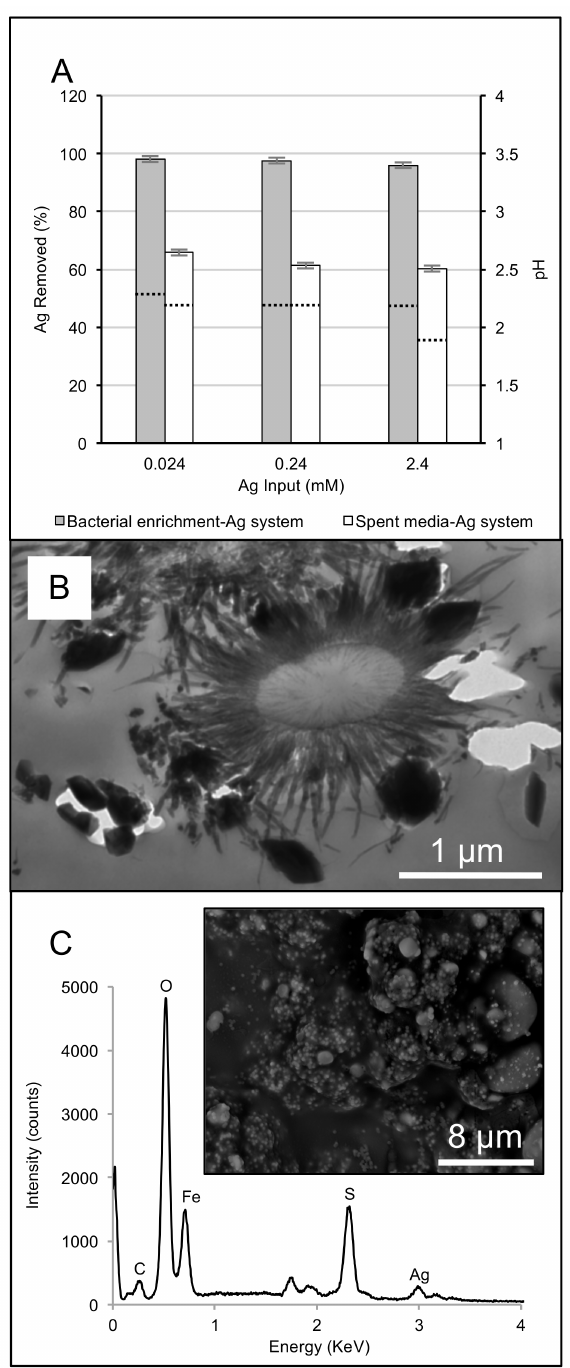
Figure 5. Average percent of Ag removed by the microbial enrichment- and spent medium-Ag systems based on ICP-AES analysis. Dashed lines represent pH within the corresponding experimental system ( A ); a high-resolution TEM micrograph of a mineralized cell and nanometer-scale argentojarosite from a microbial enrichment-Ag system exposed to 2.40 mM Ag ( B ); a low resolution BSC SEM micrograph and representative EDS spectrum of a spent medium-Ag system exposed to 2.40 mM Ag that precipitated argentojarosite. The unlabeled peaks are residual Si from the test tube and Os deposition for reducing charging, respectively ( C